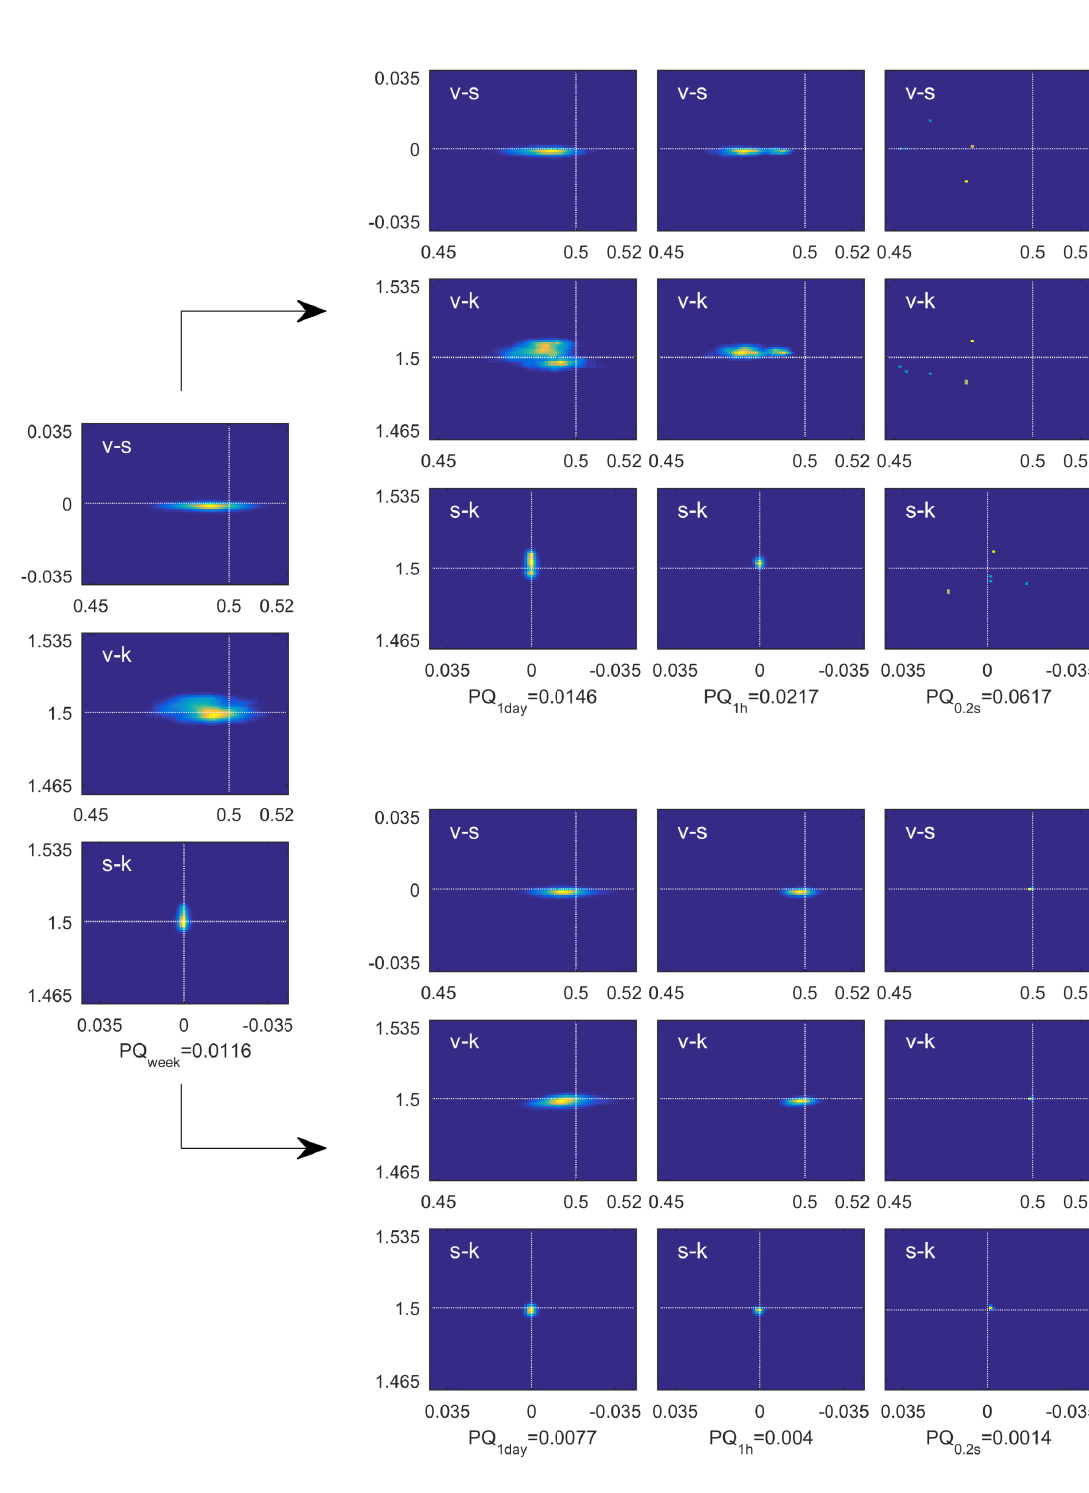
Figure 3. Scalability of the proposed method: two singular days within the analyzed week. The 3 2D-HOS graph matrix corresponding to the best (worst) day is located below (above). Within the worst (best) day, the worst (best) hour and the worst (best) 0.02 s are selected. Indeed, this Figure 3 shows the detail of the PQ temporal organization. This tree structure can be easily followed from left to right as the temporal width decreases, from reliability (one week